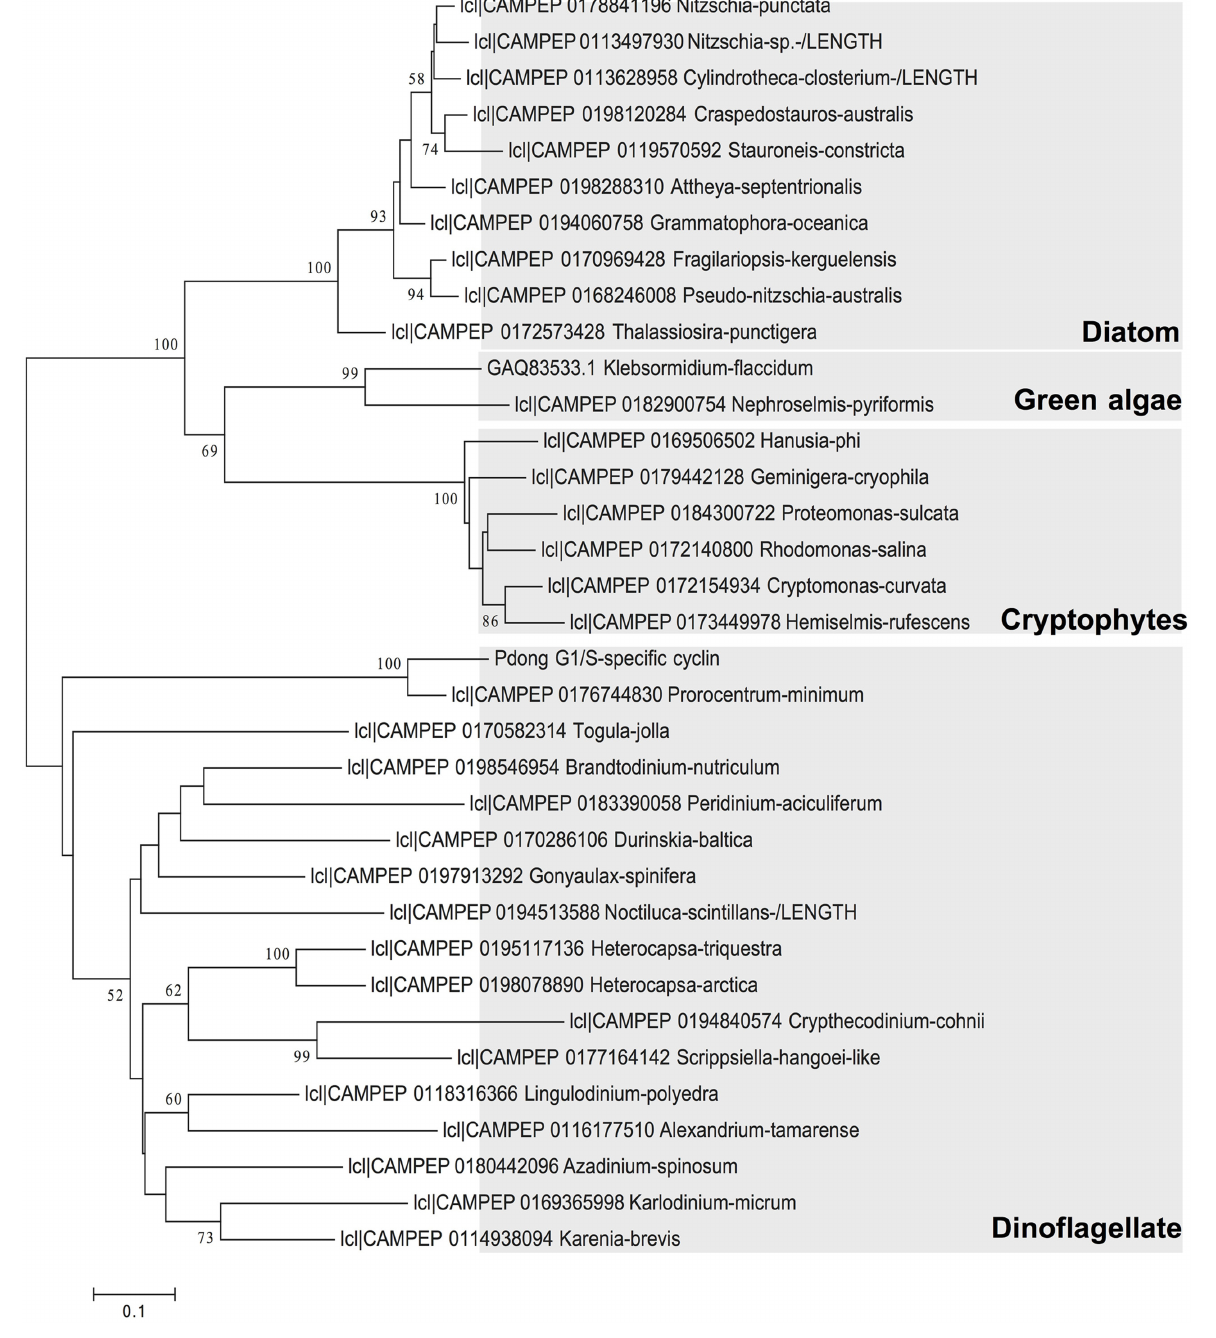
increase throughout the dark period and the first 6 h of the light period, with an apparent peak at the 6th hour of the light period (G1 phase) ( Figure 3B ). The transcript abundance showed a 2.4-fold variation in the entire sampling period. For the cellulase gene, the transcript abundance increased rapidly